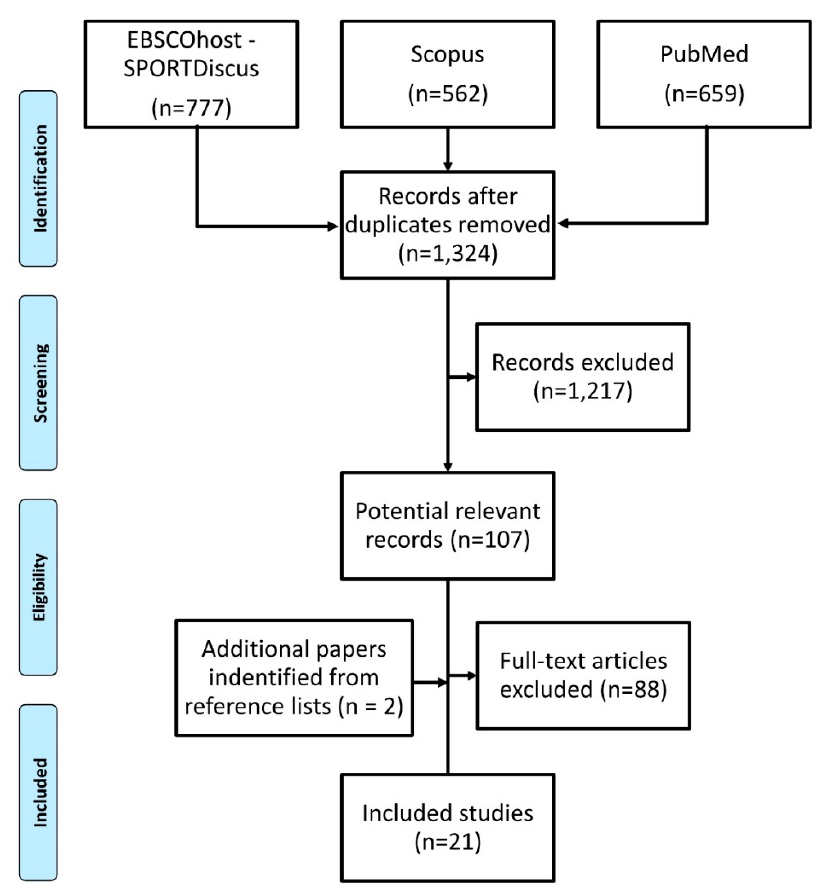
Figure 1. Flowchart illustrating the di ff erent phases of the search and study selection.